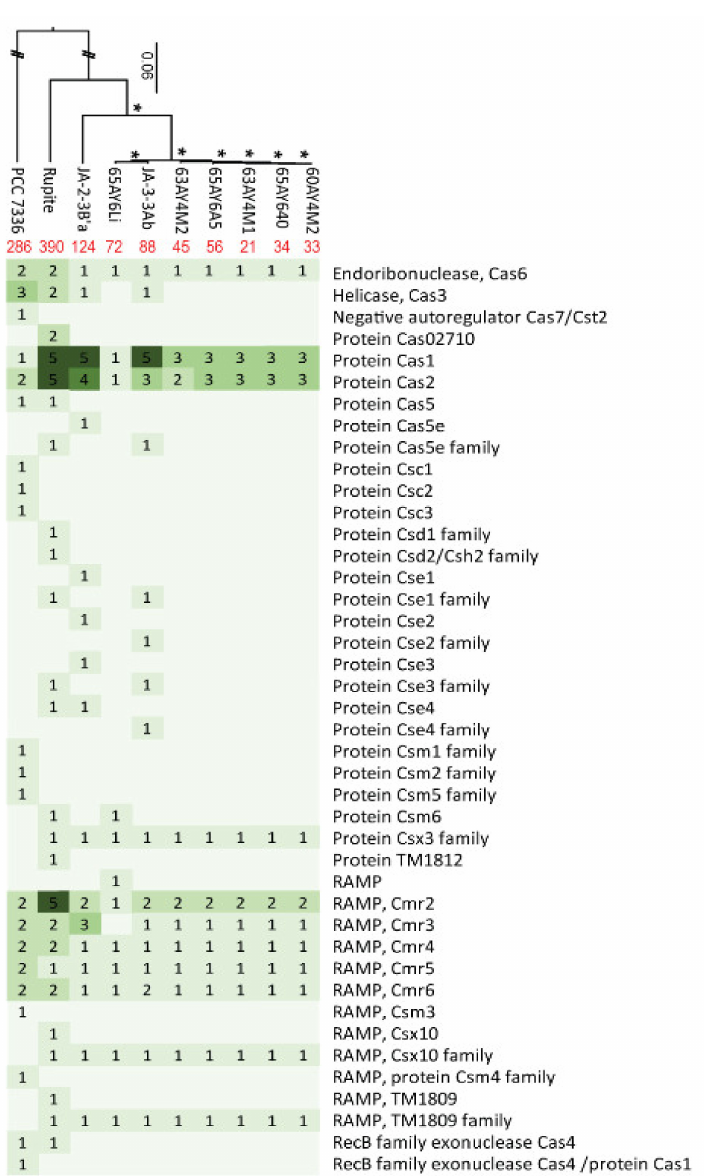
Figure 1. Maximum likelihood phylogenomic inference based on 1513 orthologous genes. The studied strain is in bold. Asterisk represents 100 ultrafast bootstraps. Each taxon has a CRISPR spacer number and a list of CRISPR genes annotated within the respective